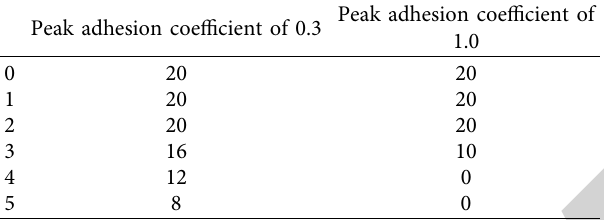
Table 3: Speed of vehicle 2 at different peak adhesion coefficients